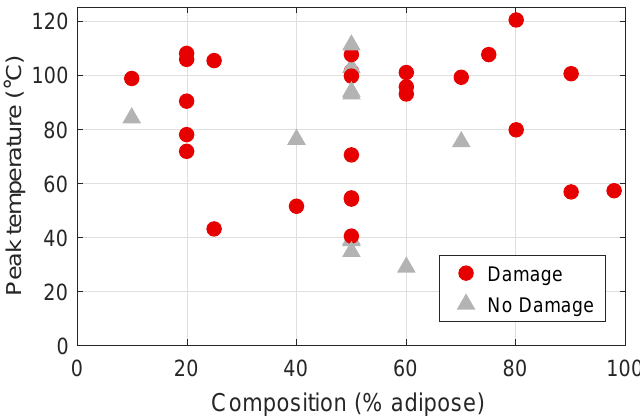
Figure 12. Peak temperature observed at each measurement location versus adipose content of the tissue at that location. The marker style indicates whether damage was or was not observed during the histological